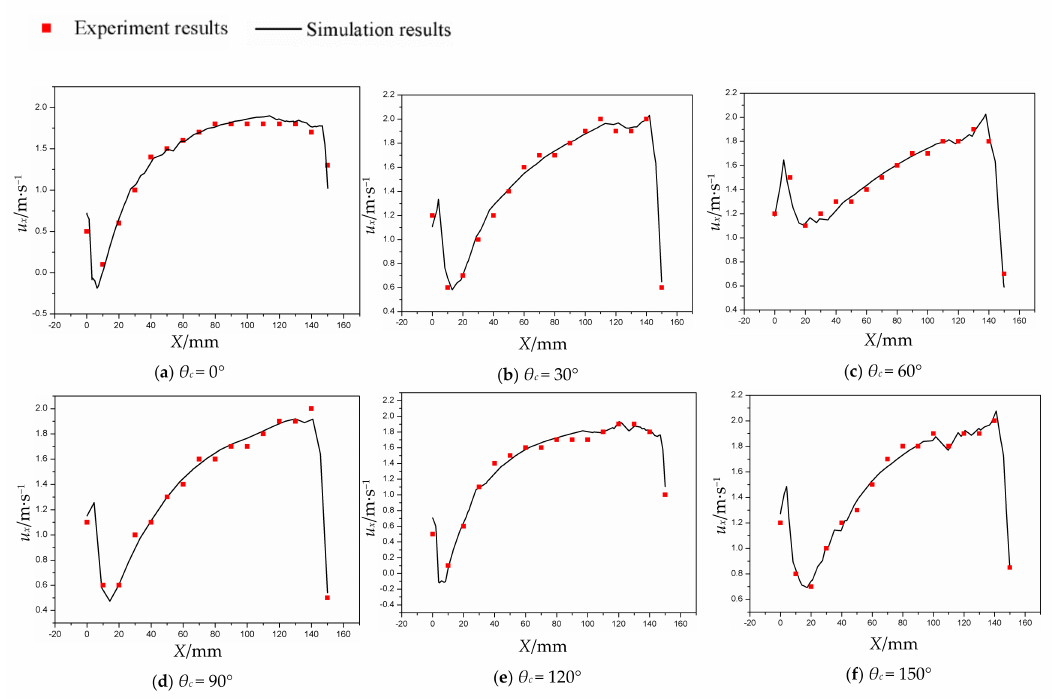
Figure 7. Comparison of the simulation results and experiment results for axial velocity.